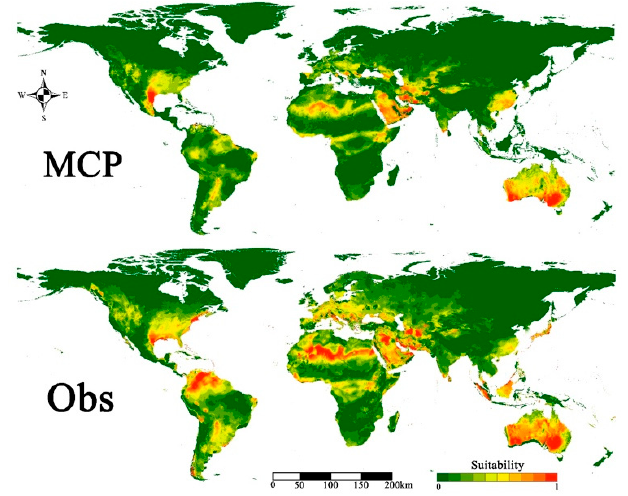
Figure 2. Potential habitat distribution of Spodoptera frugiperda in the world.